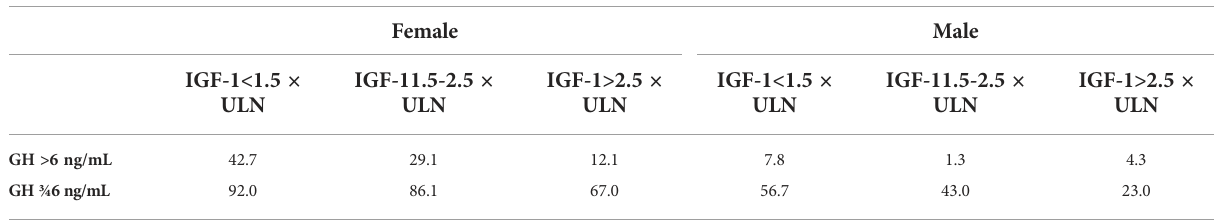
TABLE 4 Estimated probability of response to SRL expressed in percentage.